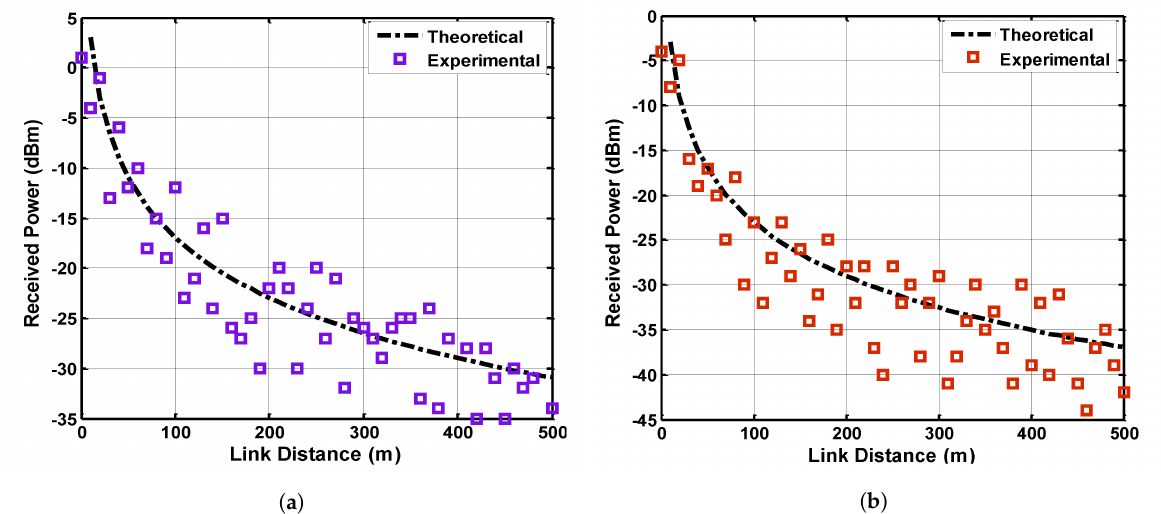
Figure 7. Received power comparison between theoretical and experimental results ( a ) 2.4 GHz, ( b ) 5 GHz.